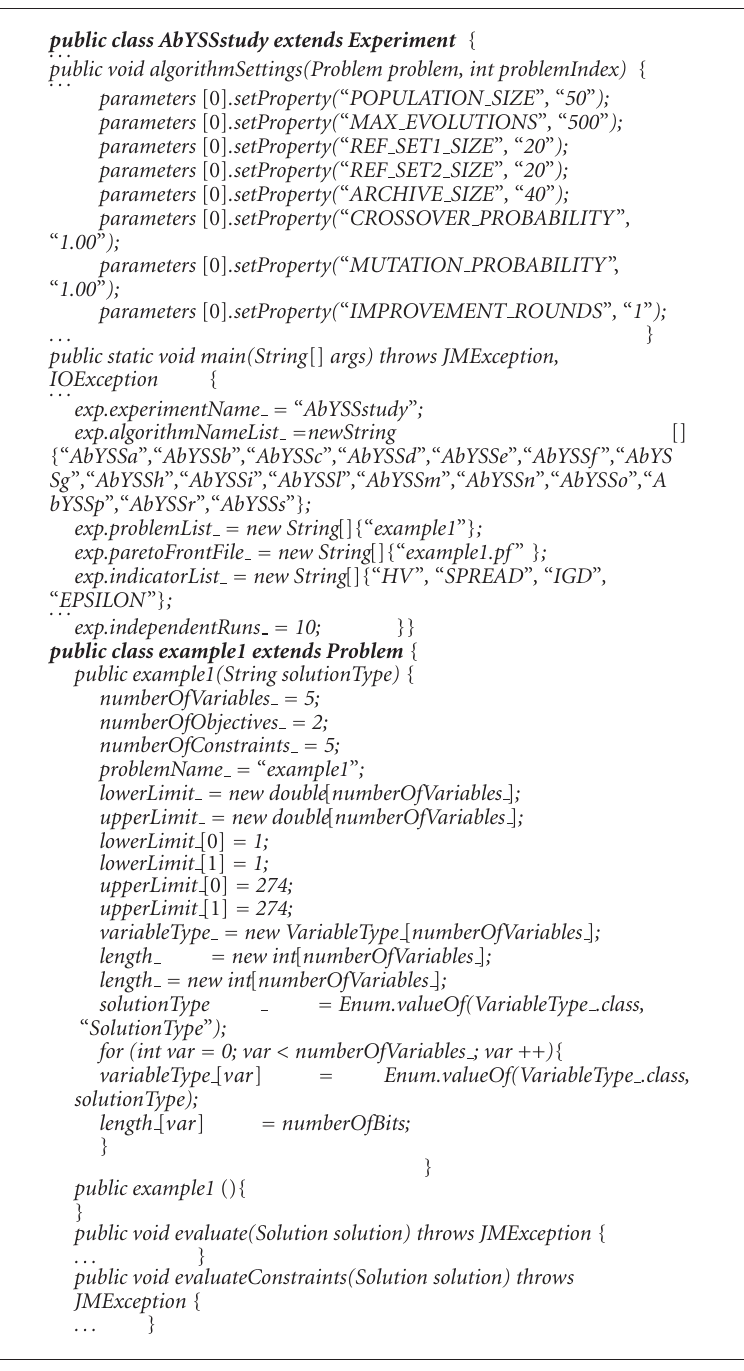
Algorithm 5: An example input for AbYSS algorithm coded in